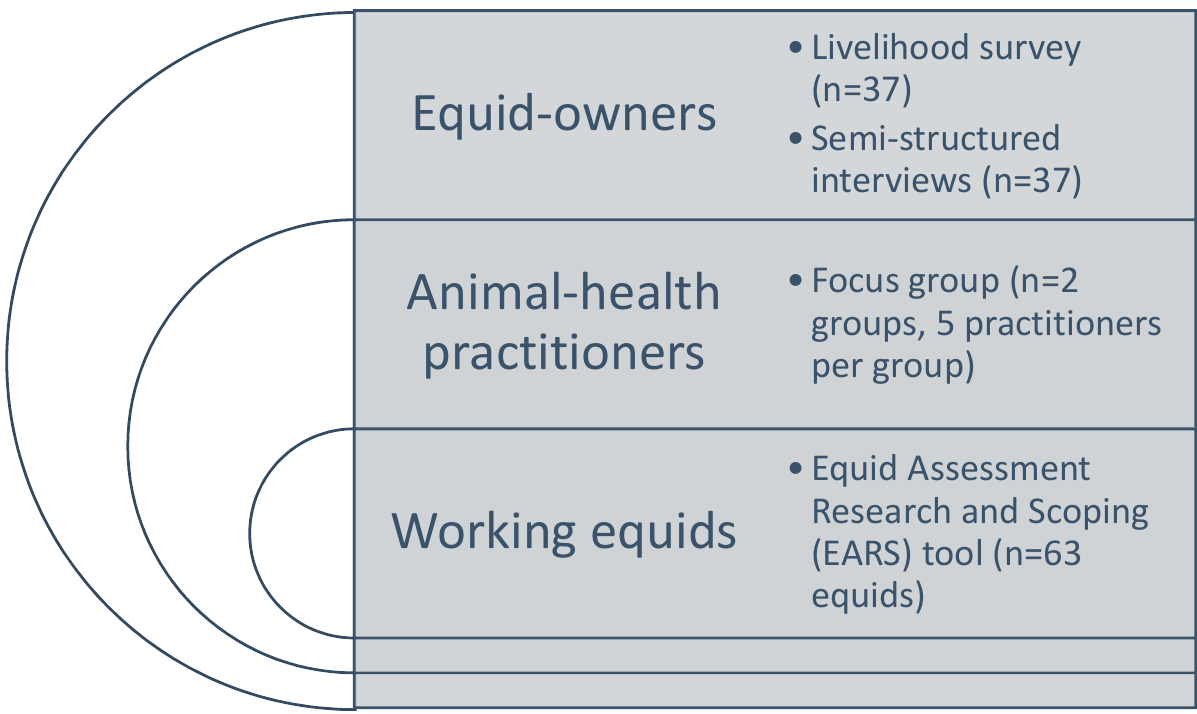
Figure 1. Study methodology.